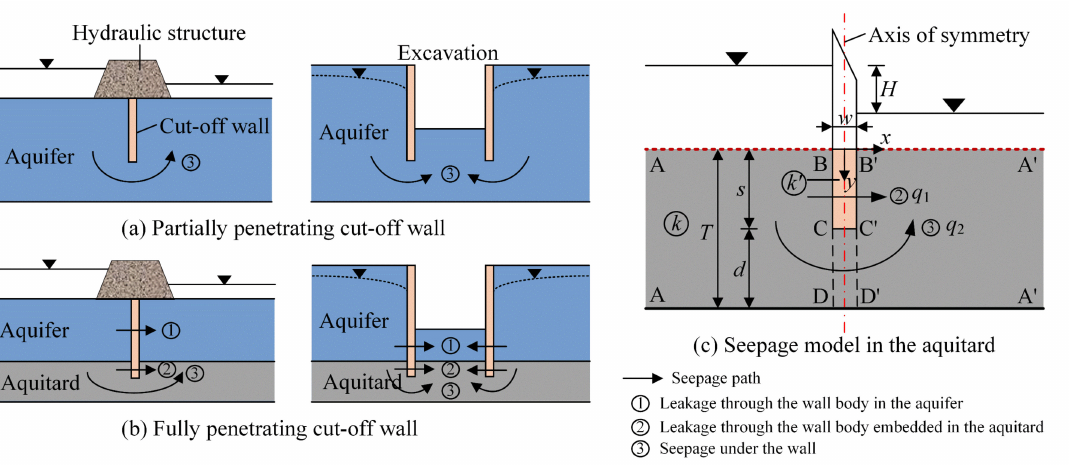
Figure 1. Seepage problems with two types of cut-off walls: ( a ) partially penetrating cut-off wall; ( b ) fully penetrating cut-off wall; and ( c ) seepage model in the